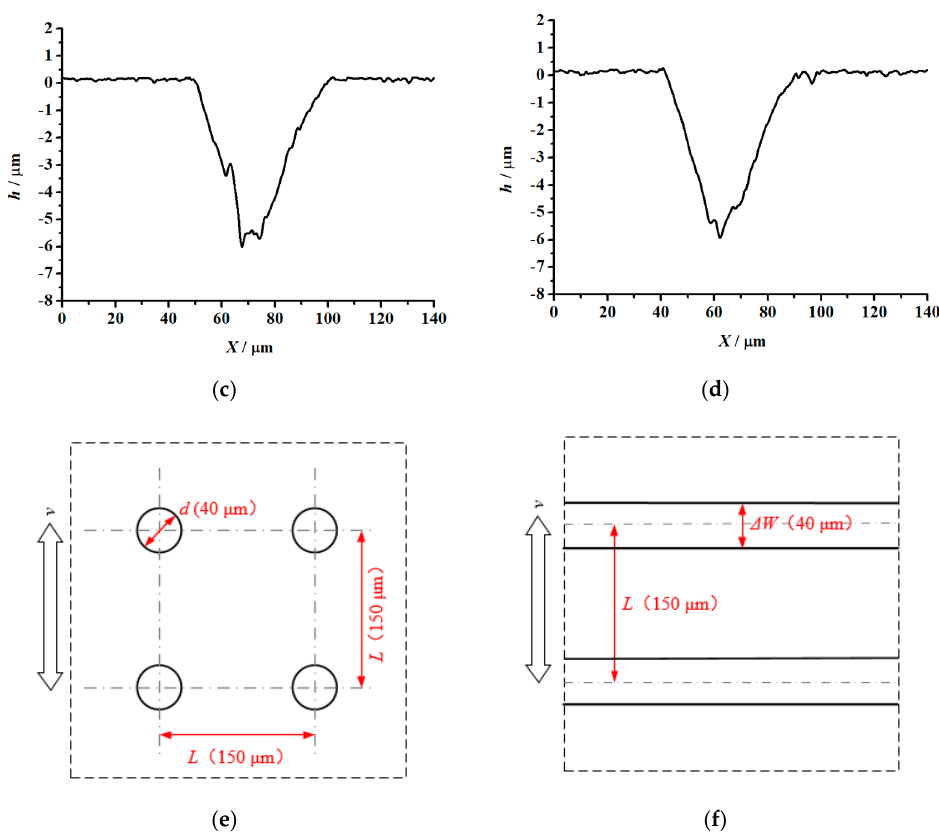
Figure 2. 3-D and 2-D profiles of the textured SiC plate surface: ( a ) 3-D profile of the circular-dimple- textured surface with a depth of 5 μ m, ( b ) 3-D profile of the groove-textured surface with a depth of 5 μ m, ( c ) 2-D profile of ( a ), ( d ) 2-D profile of ( b ), ( e ) distribution diagram of circular dimples, and ( f ) distribution diagram of grooves.